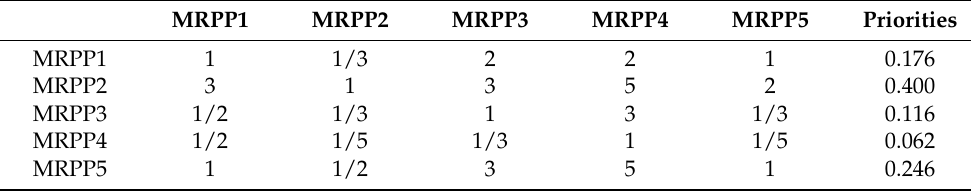
Table 6. Pairwise comparison matrix for the sub-criteria with respect to MRPP.